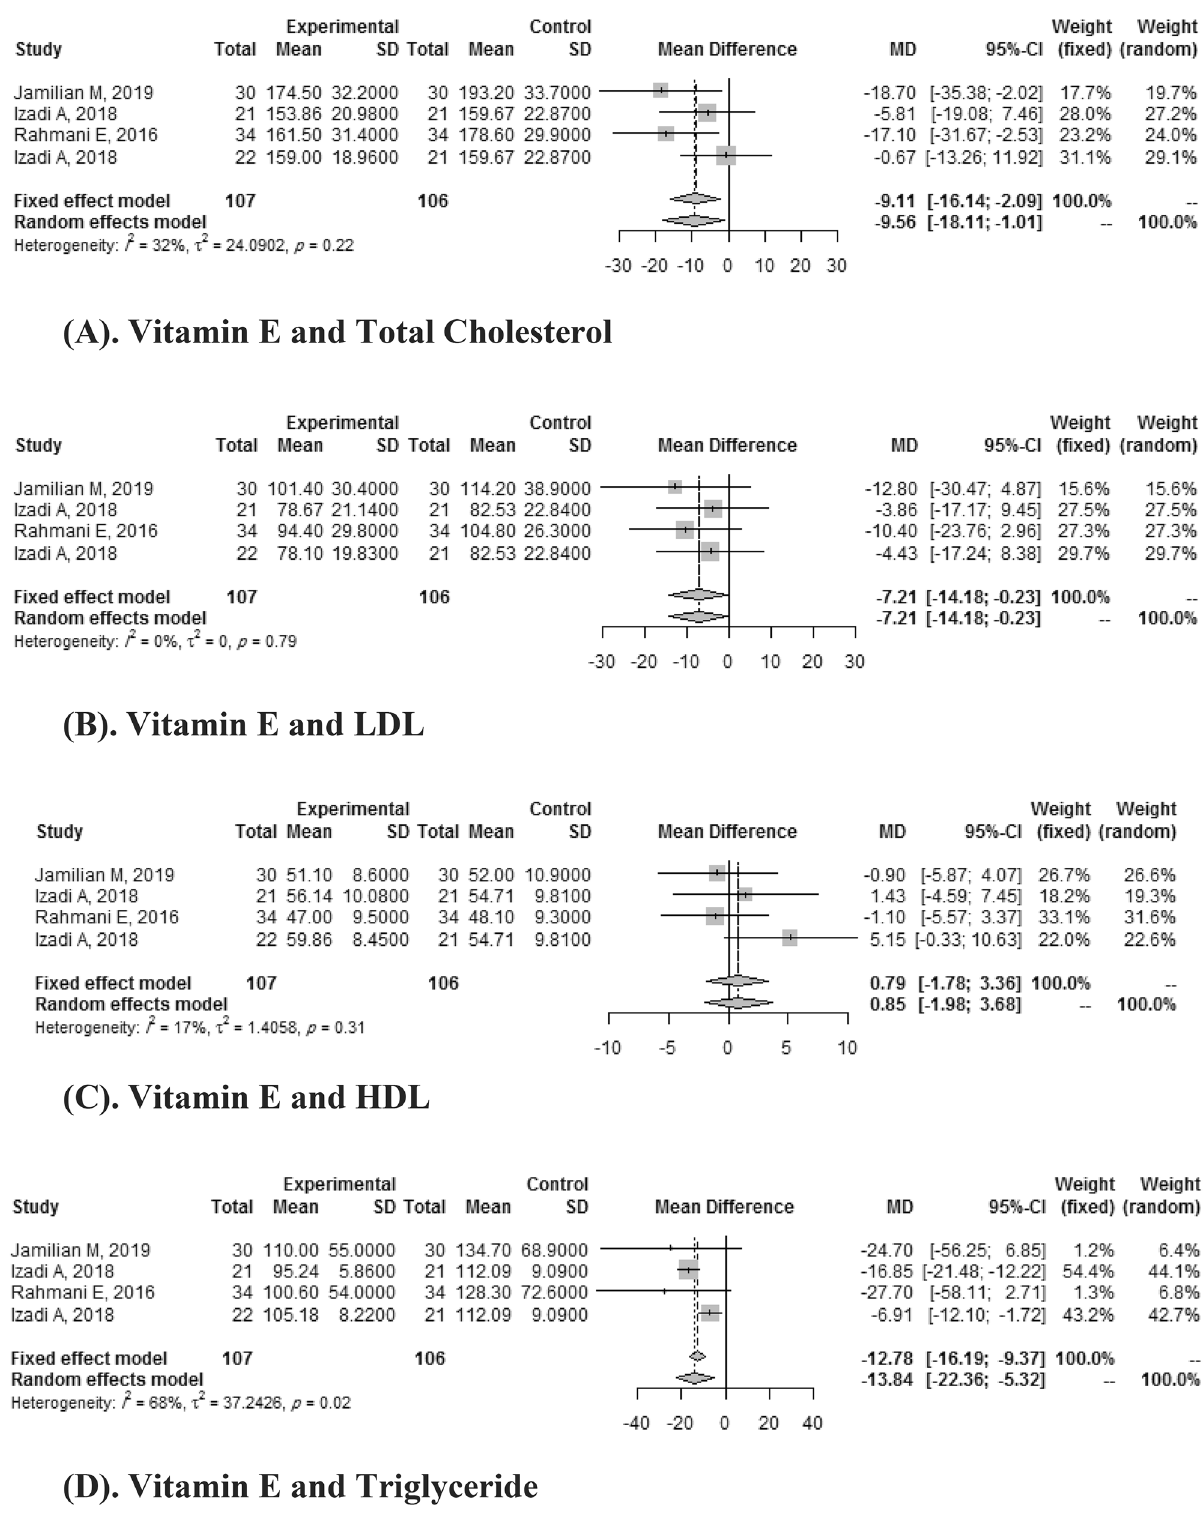
Figure 4. ( A ) Vitamin E and total cholesterol. ( B ). Vitamin E and LDL. ( C ) Vitamin E and HDL. ( D ) Vitamin E and